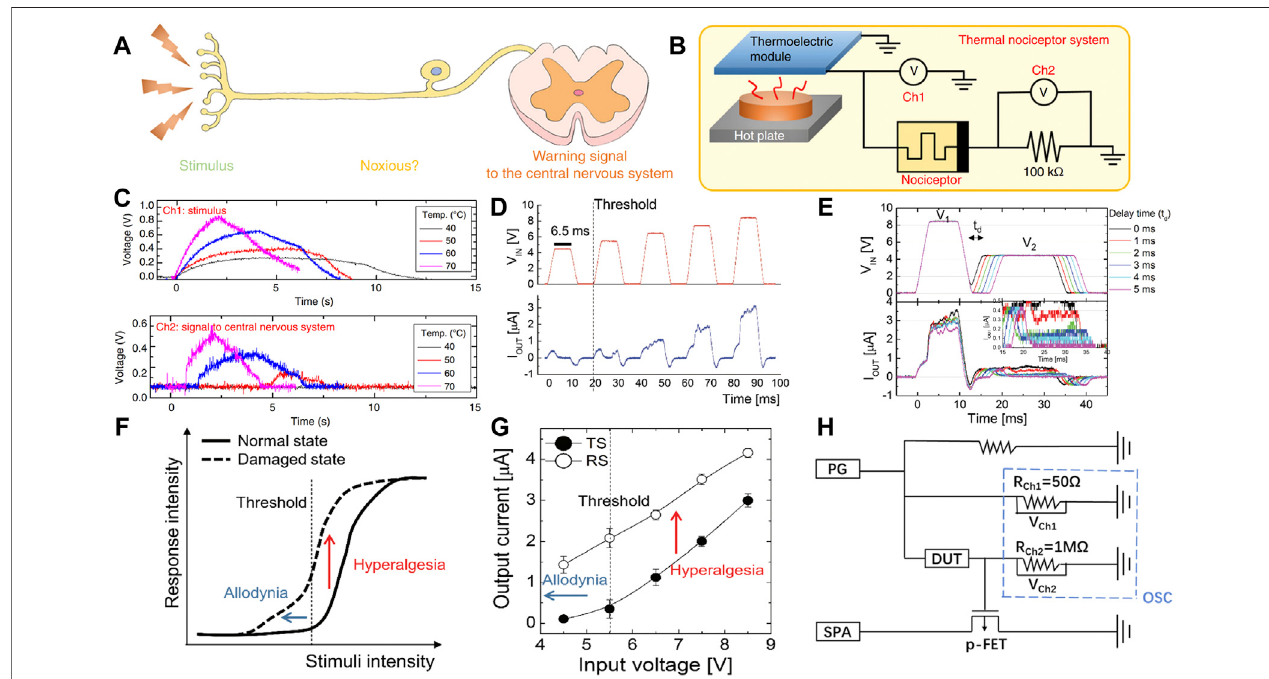
FIGURE 12 | (A) Nerve endings receive noxious stimuli, and pain receptors decide whether to transmit the stimuli to the brain. (B) Schematic diagram of arti fi cial thermal nociceptor circuit composed of thermoelectric module and diffusion memristor. (C) The voltage generated by the thermoelectric module (top) and the ON- switching and OFF-switching of the threshold switches monitored by the oscilloscope (bottom) (adapted from Yoon et al., 2018). (D) Ch1 (top panel) monitors the input voltage applied bythepulse generator, and Ch2(bottom panel) monitors the output current. (E) Thesignalrelaxation properties ofthe deviceare shown.The input voltage stimulus is shown above and the output current response is shown below. (F) Schematic comparison of nociceptor response signals in normal and impaired states. (G) Output currents asa function ofthe identical voltages at the threshold switching (TS)and resistance switching (RS)modes. (H) Simple circuit con fi guration to simulate re fl ection behavior (adapted from Kim et al.,